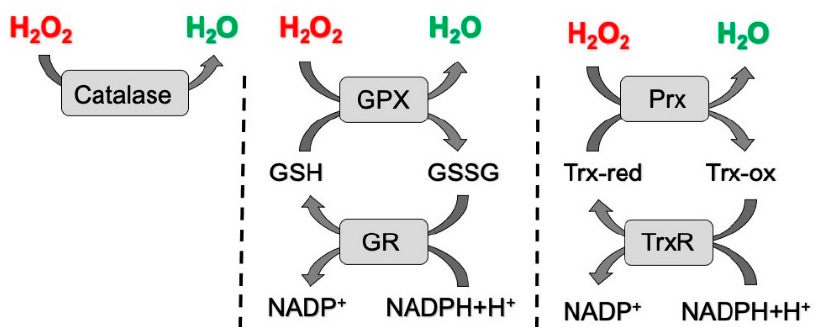
Figure 2. Cellular H 2 O 2 elimination systems. Cellular H 2 O 2 elimination can occur through different enzyme systems that allow the conversion of H 2 O 2 into H 2 O [56]. GPX: glutathione peroxidase; GSH: reduced form of glutathione; GSSG: glutathione disulfide, oxidized form of glutathione; GR: glutathione reductase; Prx: peroxiredoxin proteins; Trx-red: reduced form of thioredoxin; Trx-ox: oxidized form of thioredoxin; TrxR: thioredoxin reductase .